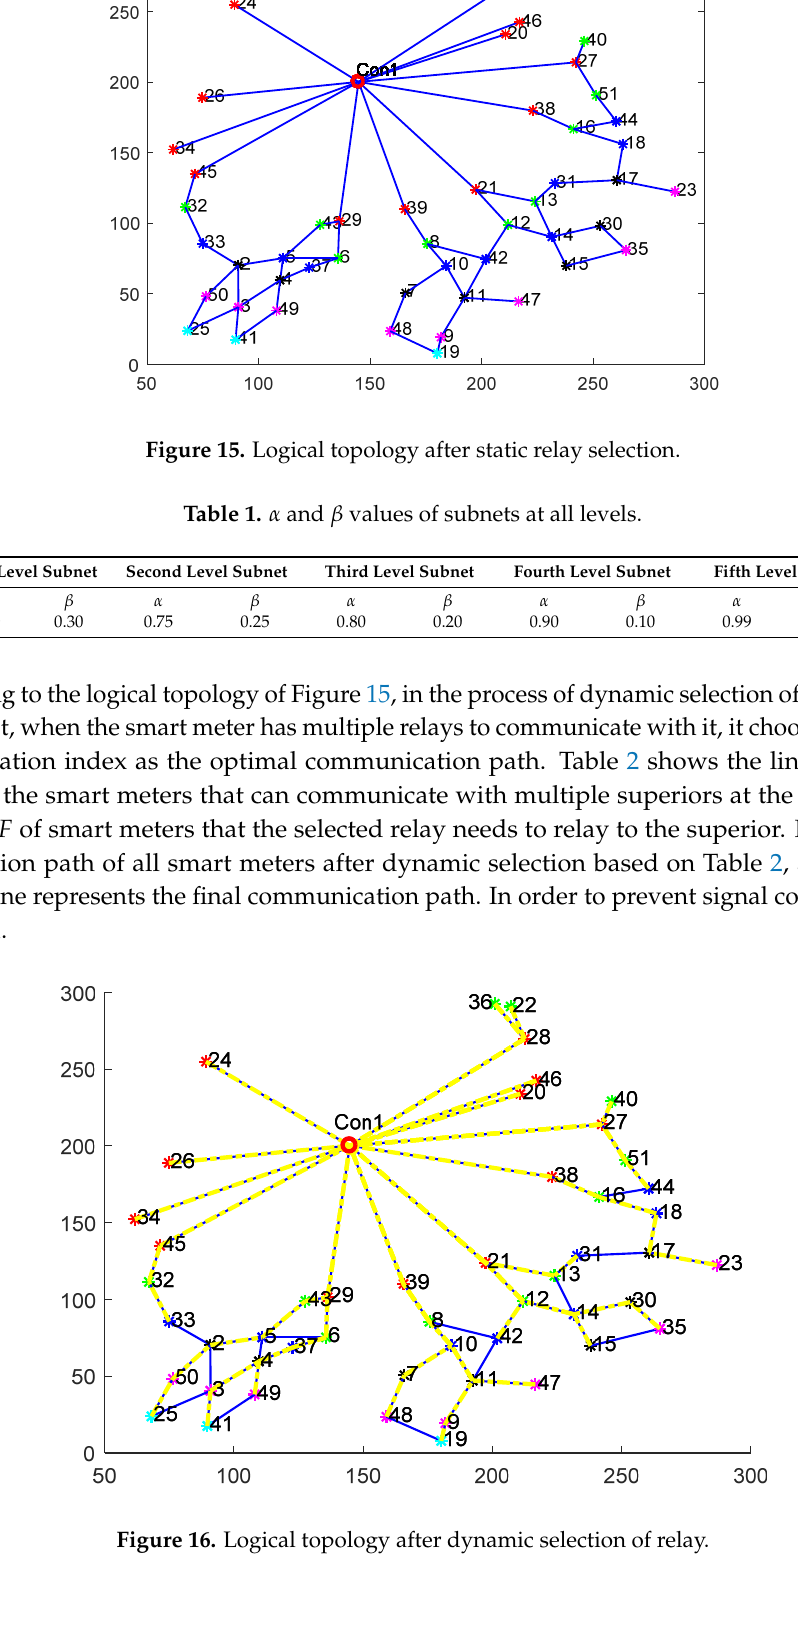
Figure 16. Logical topology after dynamic selection of relay.